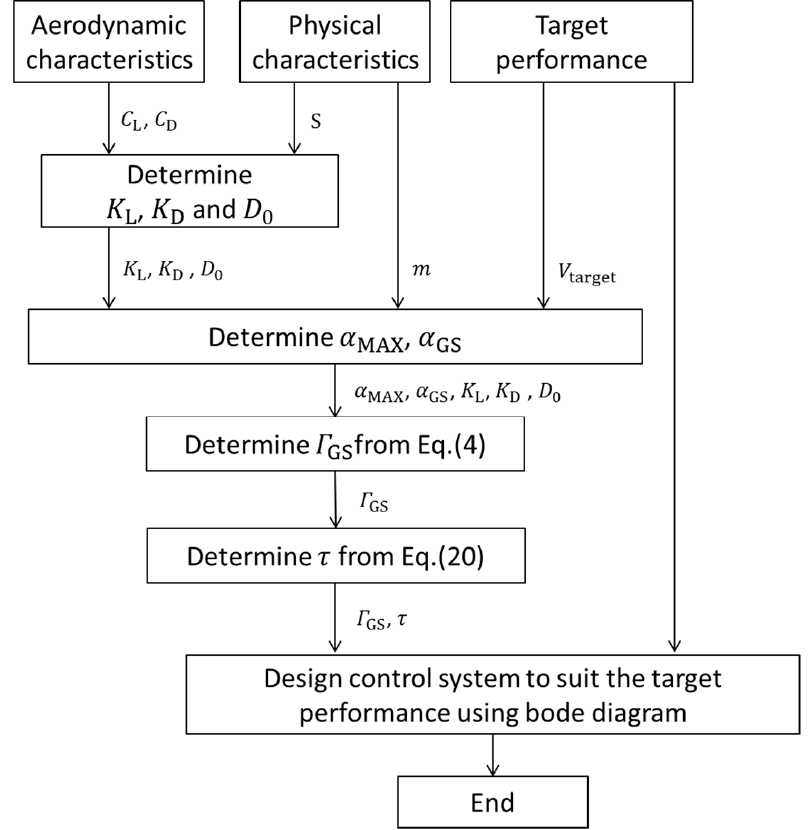
Figure 7. Design procedure.